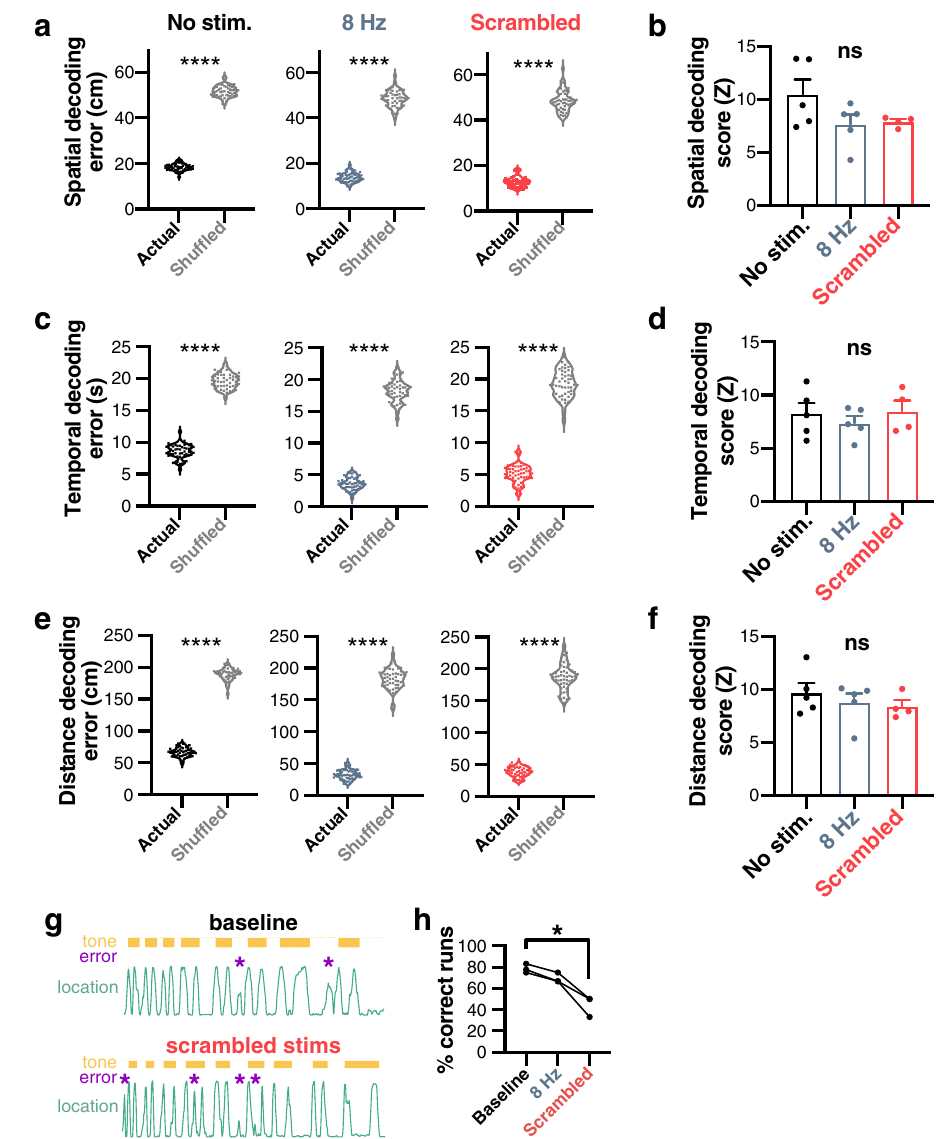
Fig. 6 | MS optogenetic stimulation alters behavior but does not disrupt spa- tiotemporal codes. Using a naive Bayesian classi fi er, location ( a , b ), the time elapsed ( c , d ), and distance traveled ( e , f ) were predicted from CA1 neuronal activity. a Decoding error (euclidean distance) for baseline, 8Hz, and scrambled optogenetic stimulation conditions for location (2ANOVA, F 5 =2172, p ≤ 0.0001; n =50 bootstrap samples from one representative mouse). c Same for time (2ANOVA, F 5 =1292, p ≤ 0.0001; n =50 bootstrap samples from one representative mouse). e Same for distance (2ANOVA, F 5 =1964, p ≤ 0.0001; n =50 bootstrap